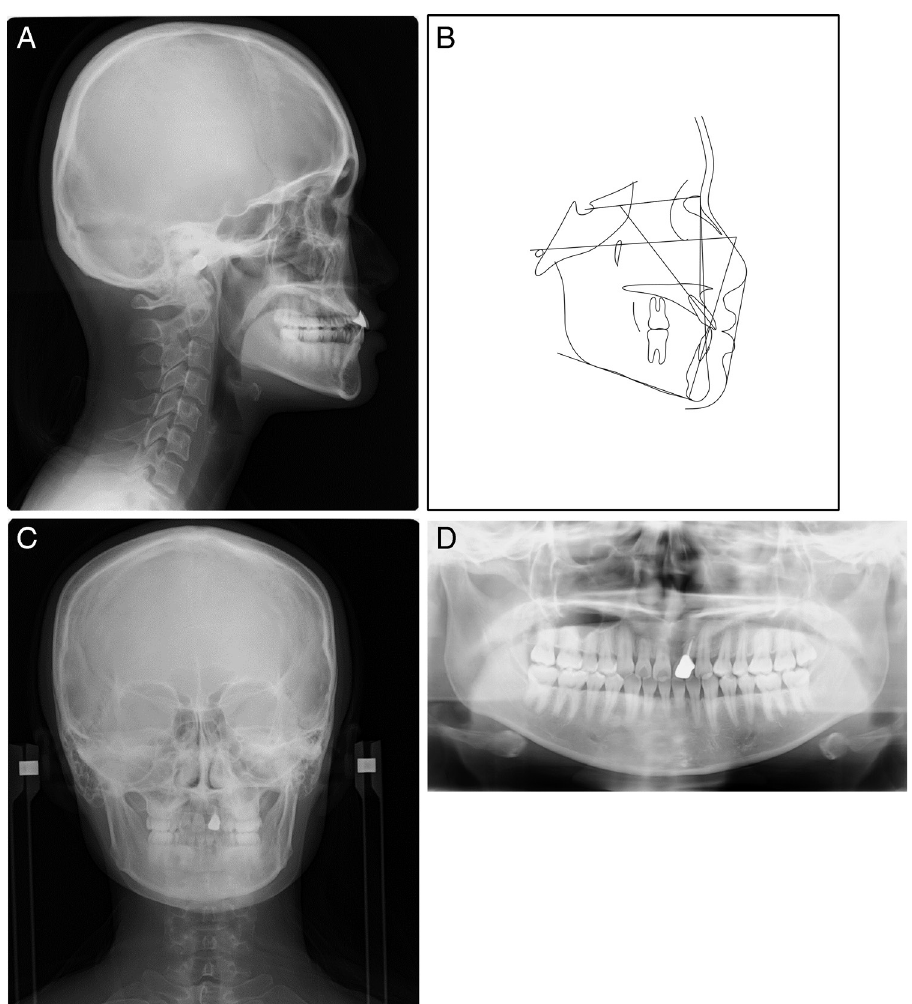
Figure 14. Postretention cephalograms, a tracing of lateral cephalogram and a panoramic radiograph. (A) Lateral cephalogram. (B) Tracing. (C) Pos- teroanterior cephalogram. (D) Panoramic